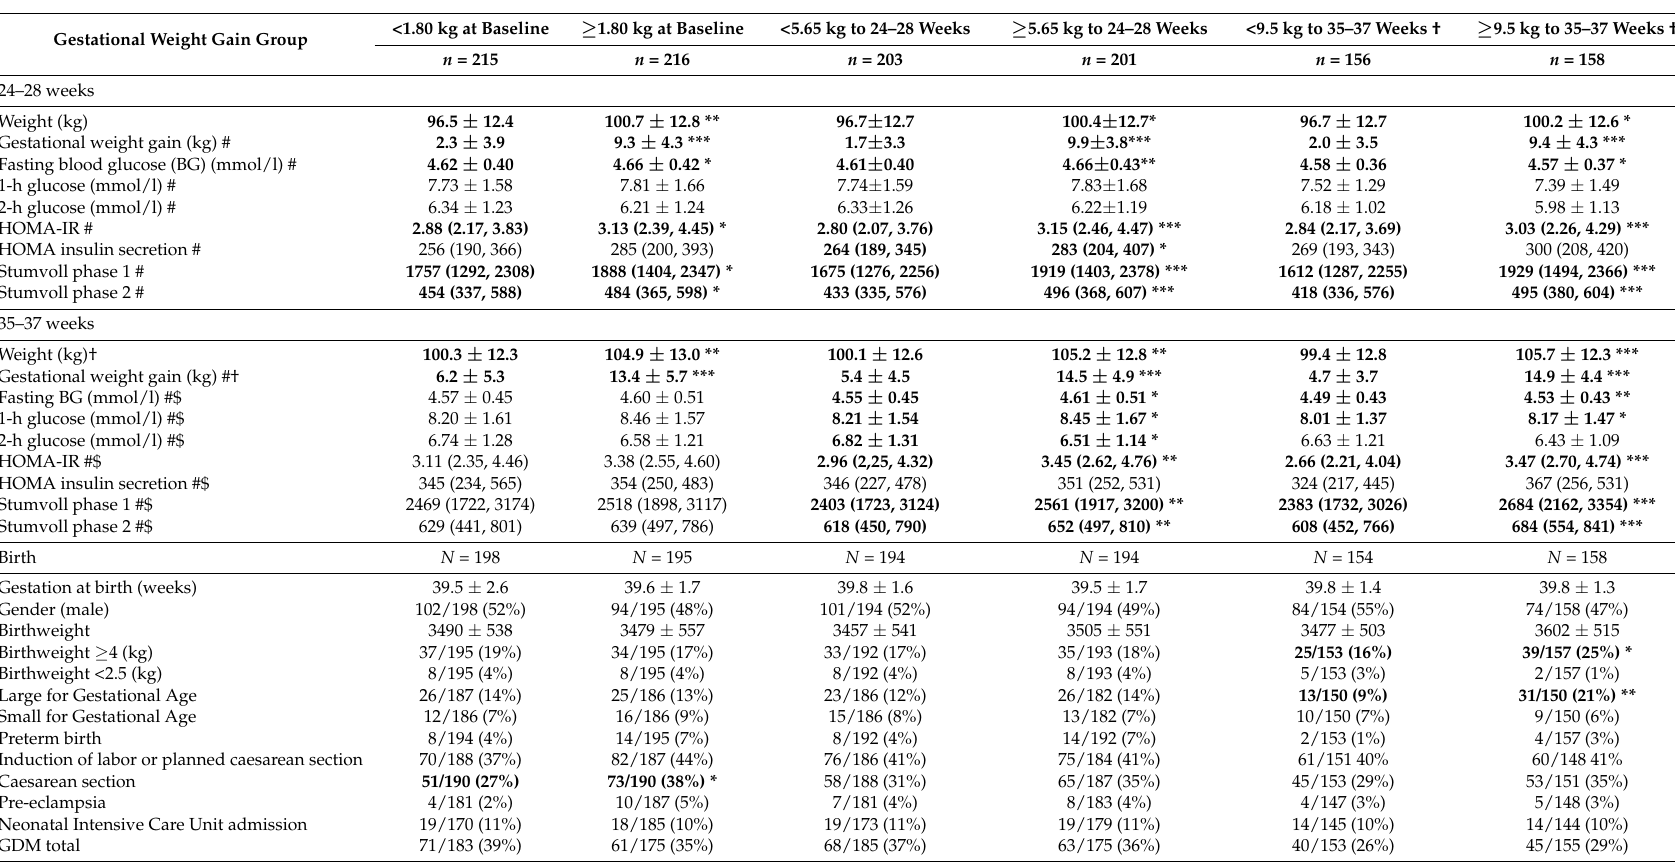
Table 2. Metabolic status at 24–28 weeks, 35–37 weeks, and birth outcomes in DALI participants, according to gestational weight gain from